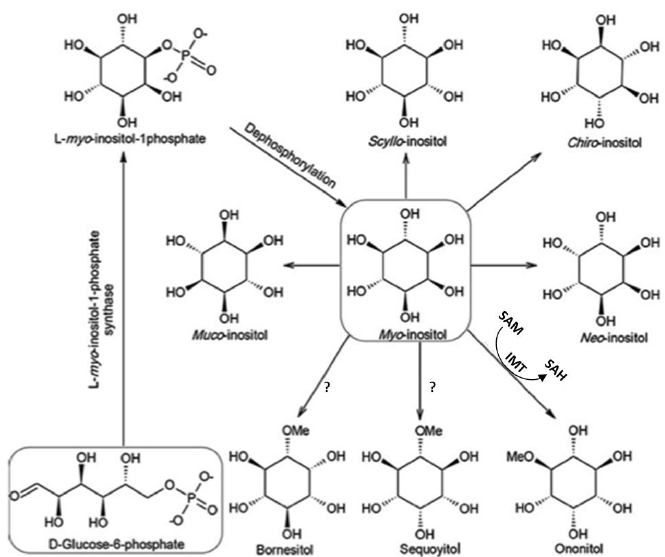
Figure 2. The biosynthetic pathway of myo -inositol and its methylated derivatives. The biosynthetic pathway of myo -inositol and its methylated derivatives. IMT — myo -inositol O -methyltransferase, SAM — S-adenosylmethionine, SAH — S-adenosylhomocysteine [10].